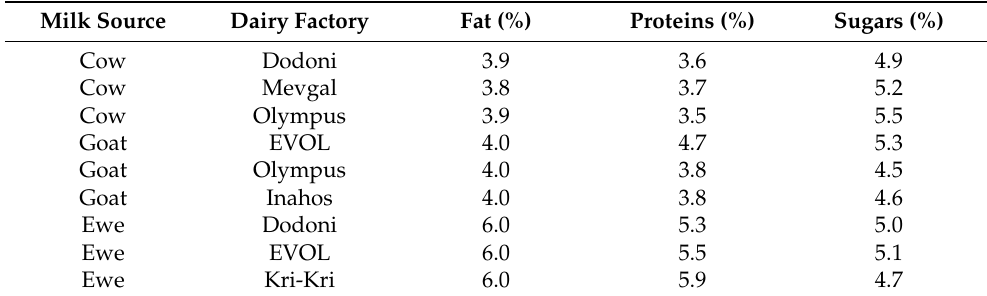
Table 1. Gross composition of the different full-fat cow, goat and ewe yogurts.